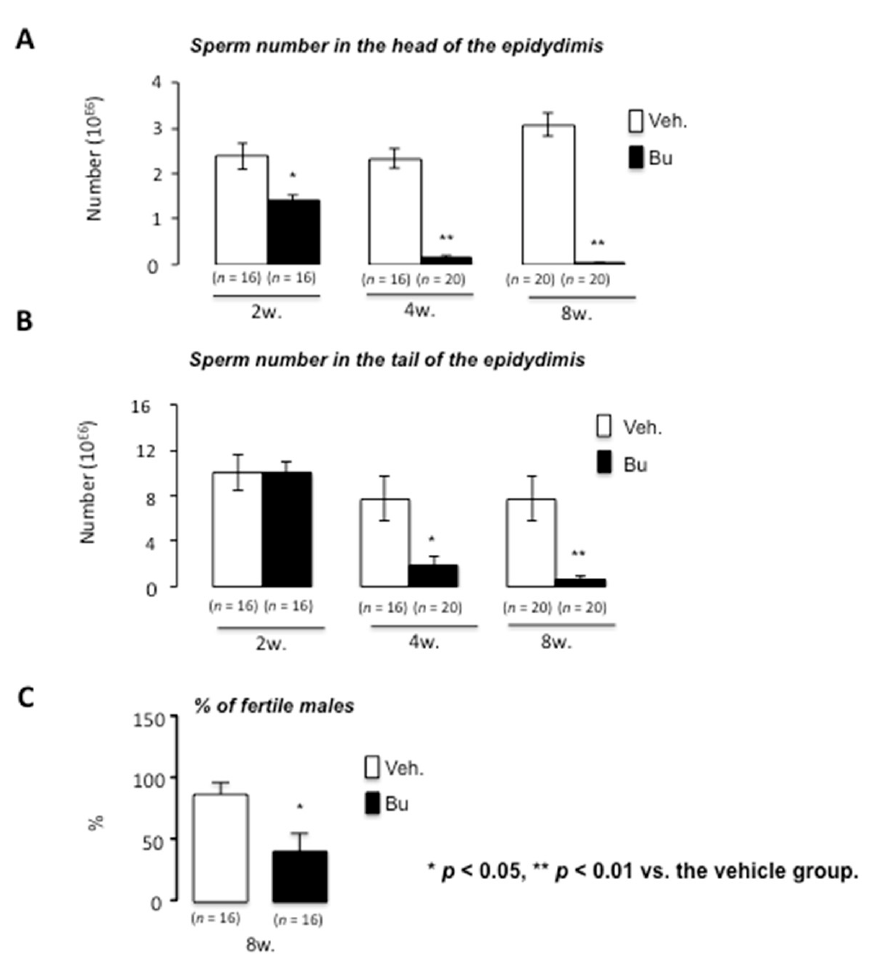
Figure 3. Busulfan alters germ cell production and male fertility in mice. ( A ) Sperm count in the epididymis head of C57BL/6J males at 2, 4, and 8 weeks after busulfan or vehicle treatments. ( B ) Sperm count in the epididymis tail of C57BL/6J males at 2, 4, and 8 weeks after busulfan or vehicle treatments. ( C ) Percentage of fertile males 8 weeks after vehicle or busulfan treatment following breeding with C57BL/6J females. For all panels, the data were obtained from at least the independent experiments; the number of animals per group is indicated in parentheses below the bars of the graphs. The data are expressed as the means ± SEM. Statistical analysis: * p < 0.05, ** p < 0.01 vs. the vehicle group. Veh.: vehicle and Bu: busulfan.